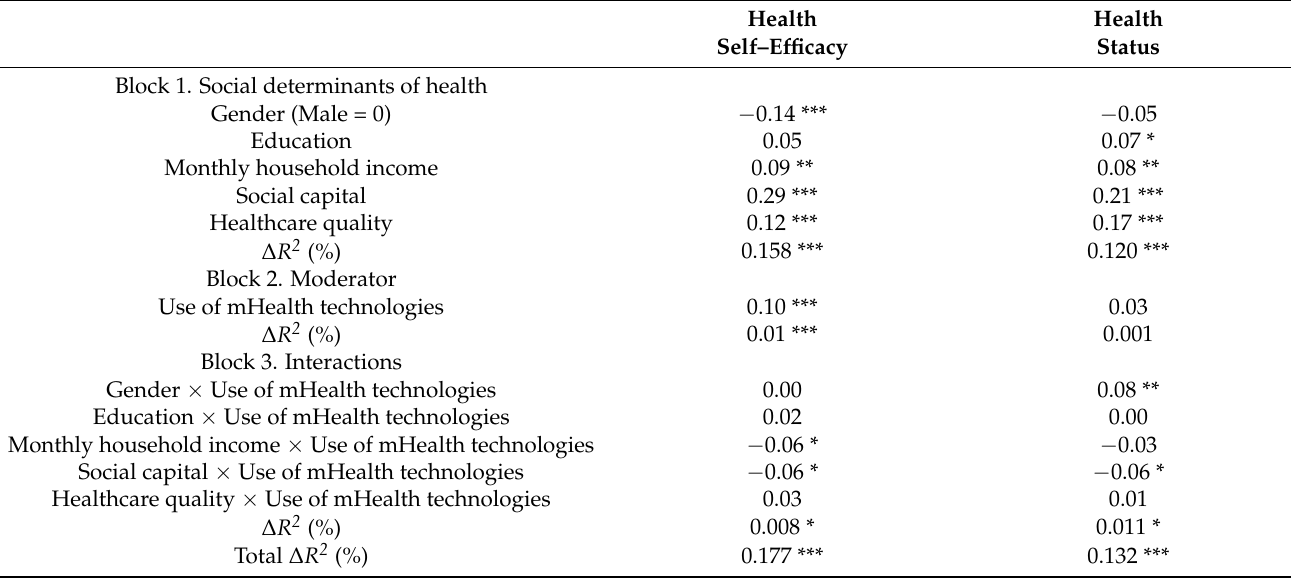
Table 3. Results of hierarchical regression analyses of health